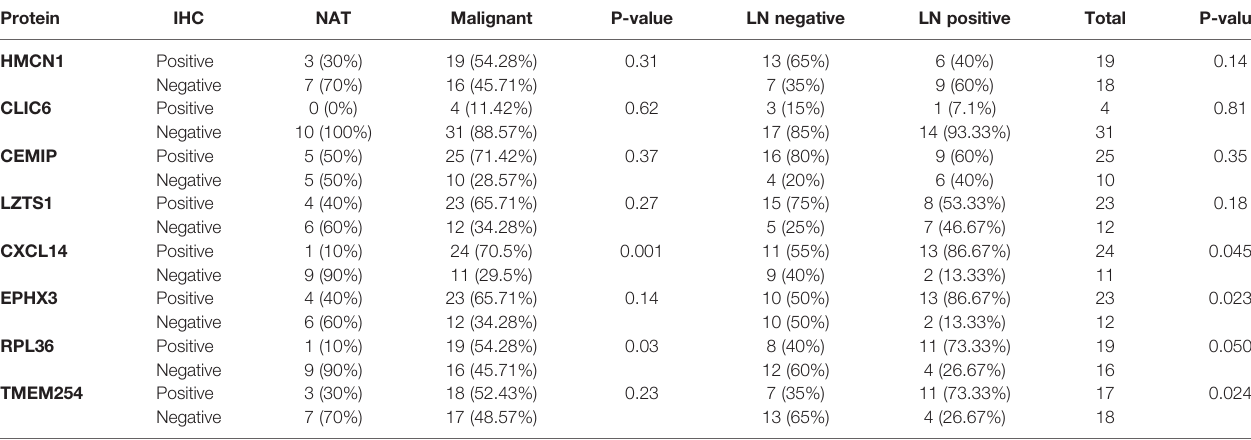
TABLE 1 | The expression levels of the 8 shortlisted genes and its association with LN status in our patient cohort consist of 35 obese patients diagnosed with endometrioid endometrial cancer Protein IHC